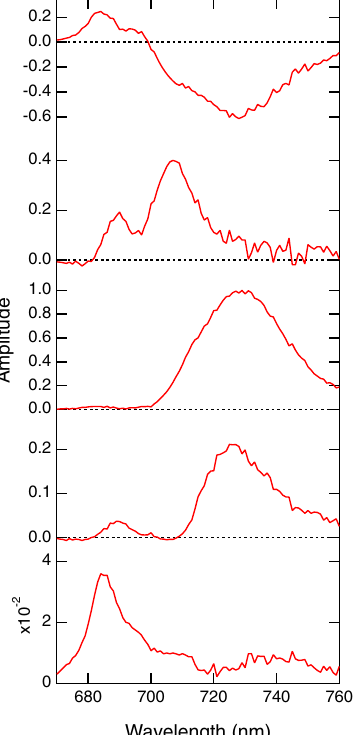
Fig. 7 | Fluorescence decay-associated spectra of PSI-IsiA. TRF was measured at 77K upon excitation at 445nm, followed by global analysis to construct the FDA spectra. The analyzed time constants for the spectra were 55ps, 120ps, 520ps, 1.2ns, and 3.9ns from top to bottom. The FDA spectra were normalized by the maximum amplitude of the 520-ps